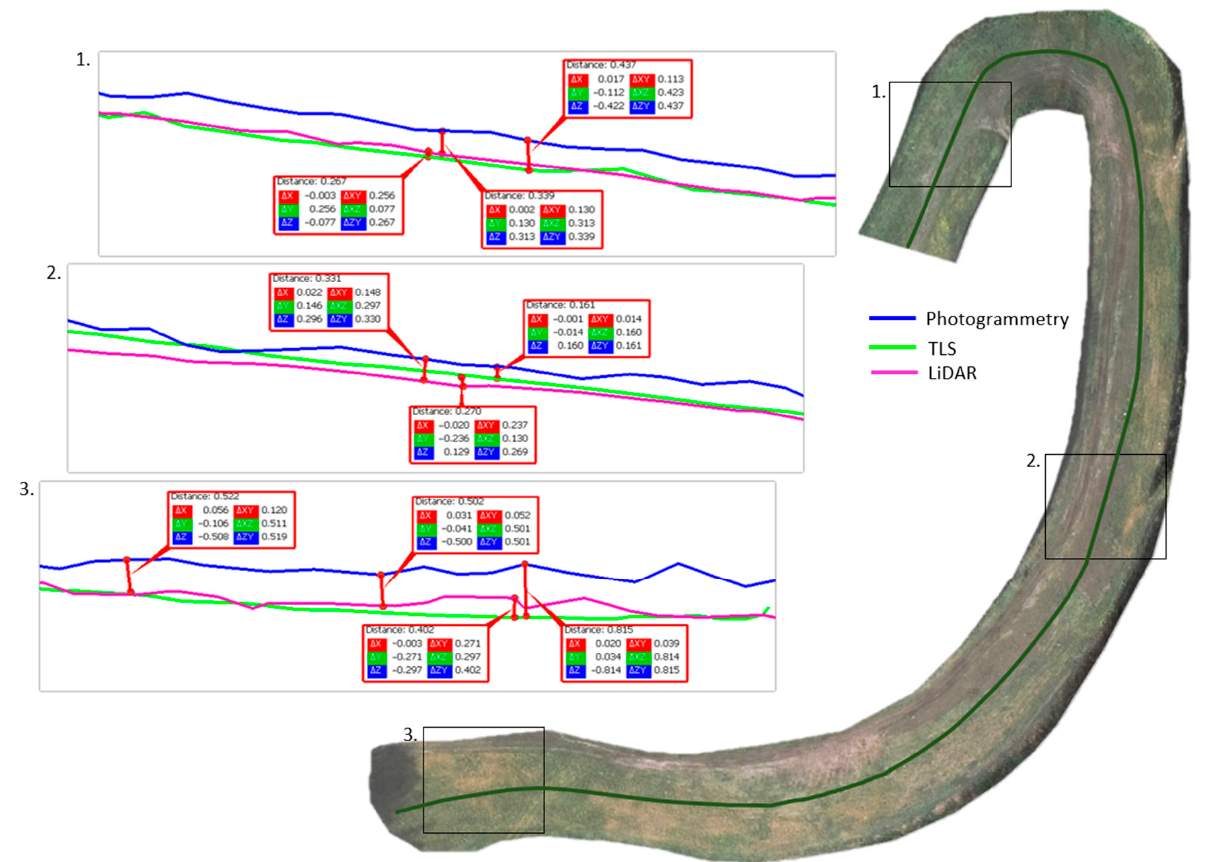
Figure 9. Height differences on selected profiles between point clouds extracted based on methods